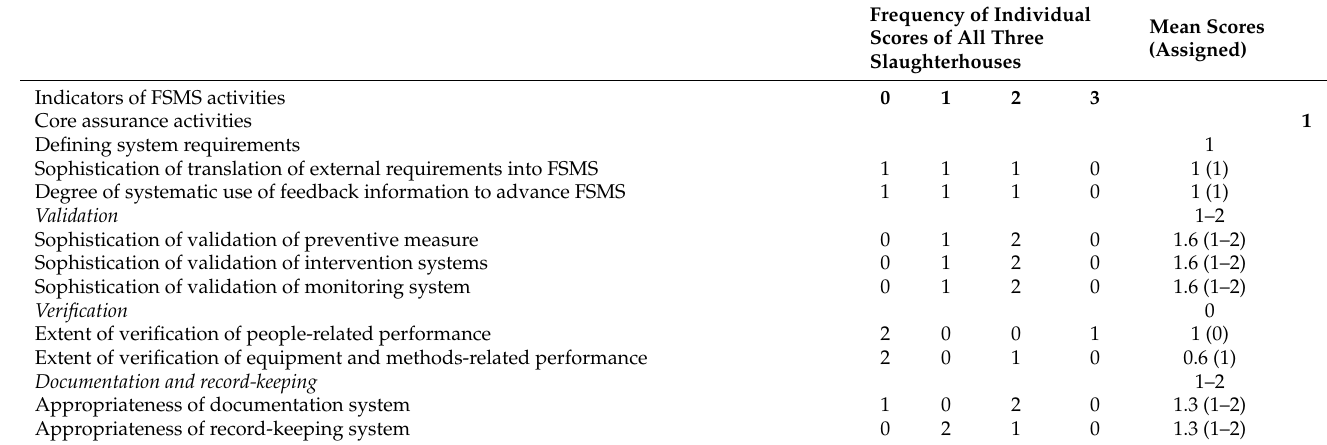
Table 2. Analysis of the core assurance FSMS activities at the three largest slaughterhouses in Kampala.